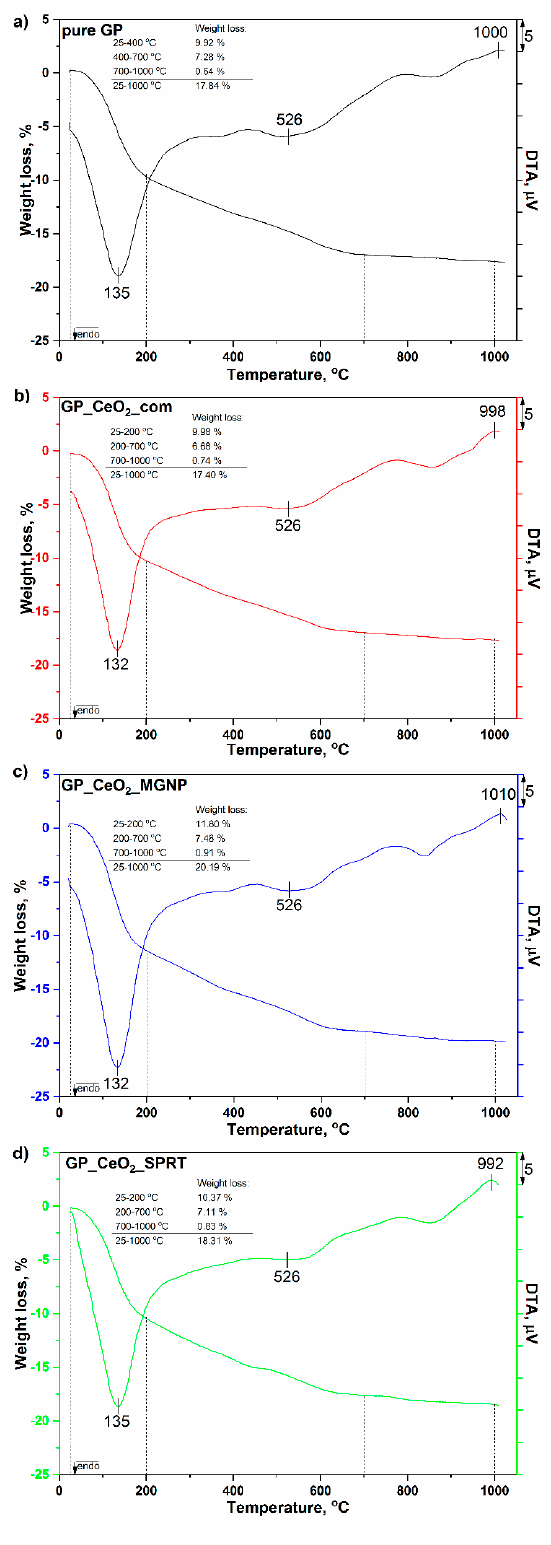
Figure 9. Results of the DTA / TGA analyses of: ( a ) GP, ( b ) GP_CeO 2 _com, ( c ) GP_CeO 2 _MGNP, and ( d ) GP_CeO 2